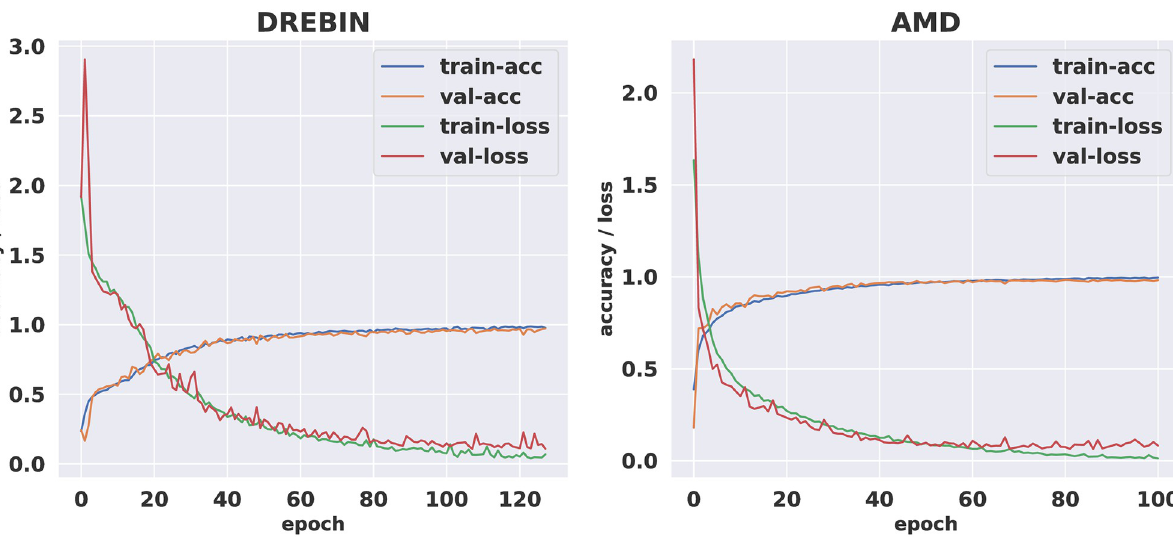
models in case of (a) only changing the type of conversion while keeping the same dataset and the applied CNN algorithm, (b) keeping the same conversion type and dataset while changing the applied CNN algorithm (c) keeping the type of conversion and applied CNN algorithm while changing the dataset itself. For example, the accuracy improvement reached 52.80% when CD type is used instead of the whole APK utilizing InceptionResNetV2 algorithm and AMD dataset. On the other hand, the accuracy improved by 107% when DAM type was used by our proposed algorithm (scratch) in comparison to the InceptionResNetV2 algorithm. The